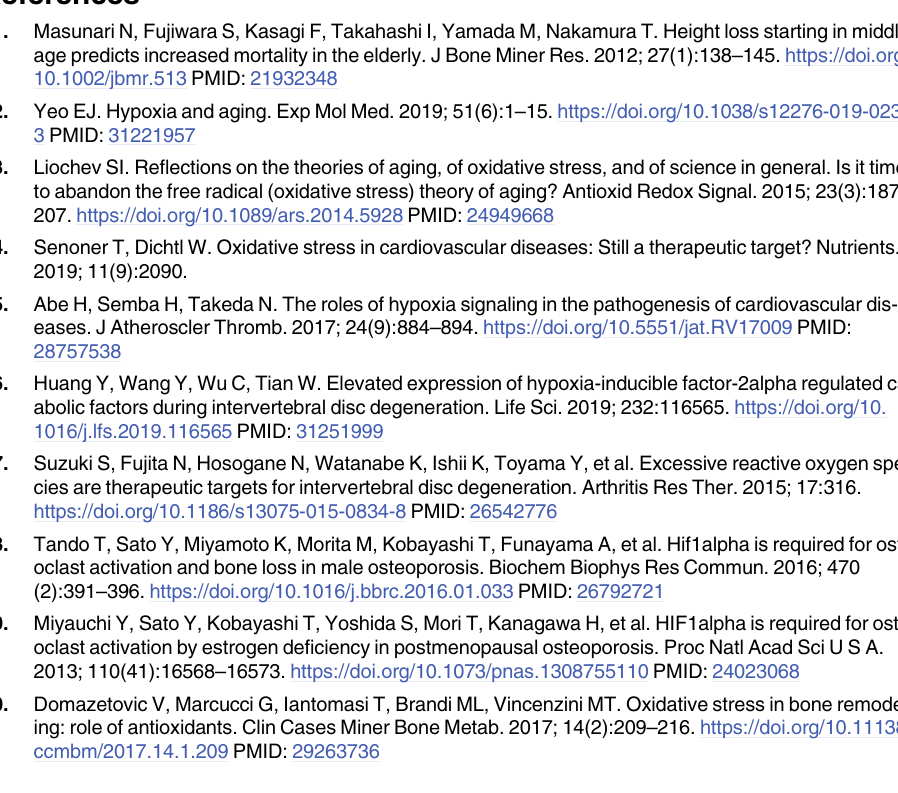
S3 Table. Correlation between height decrease per year (mm/year) and hemoglobin